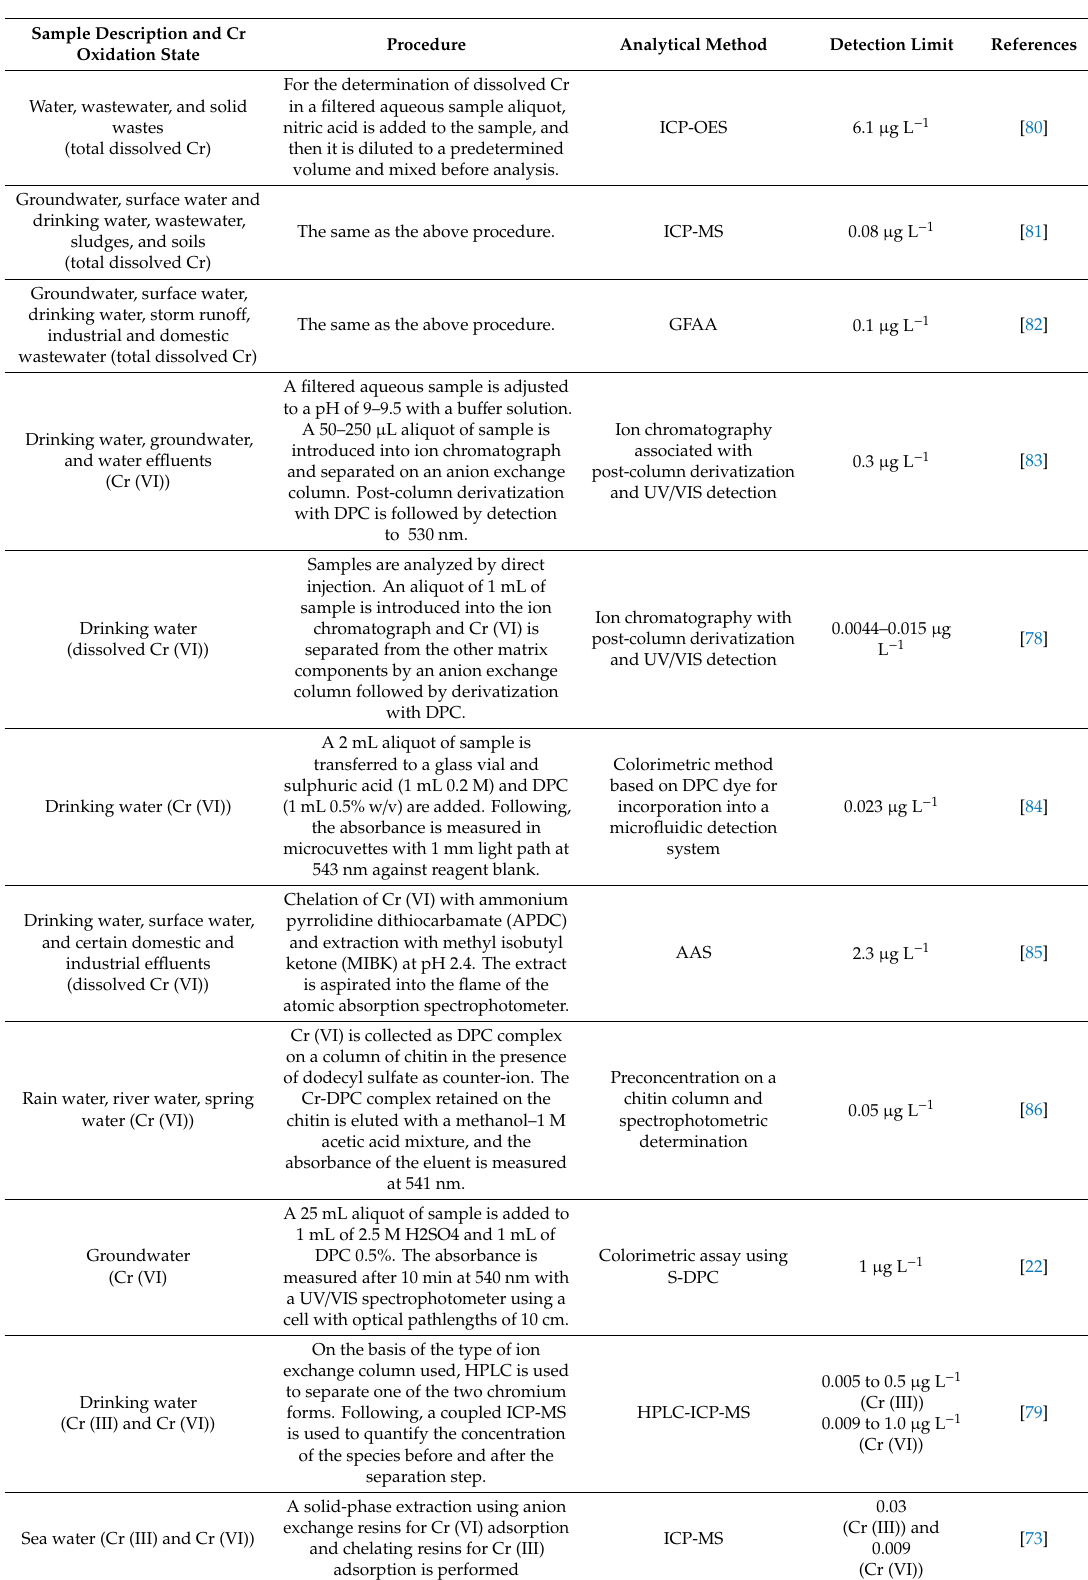
Table 3. Analytical methods for total Cr, Cr (III), and Cr (VI) in water samples. AAS, atomic absorption spectroscopy; GFAAS, graphite furnace atomic absorption spectrometry; ICP-MS; inductively coupled plasma mass spectrometry; ICP-AES, inductively coupled plasma atomic emission spectroscopy; HPLC, high-performance liquid chromatography; DPC, 1,5